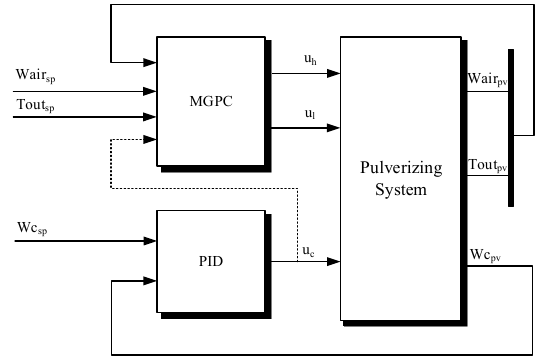
Fig.2 Overall control scheme for the pulverizing system